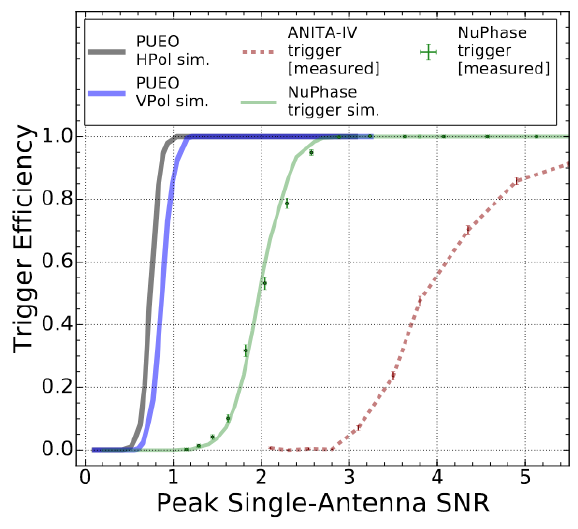
Figure 3. Simulated trigger e ffi ciency of PUEO using a 16- antenna beamforming trigger compared to the trigger e ffi ciency of ANITA-IV and ARA (Askaryan Radio Array)